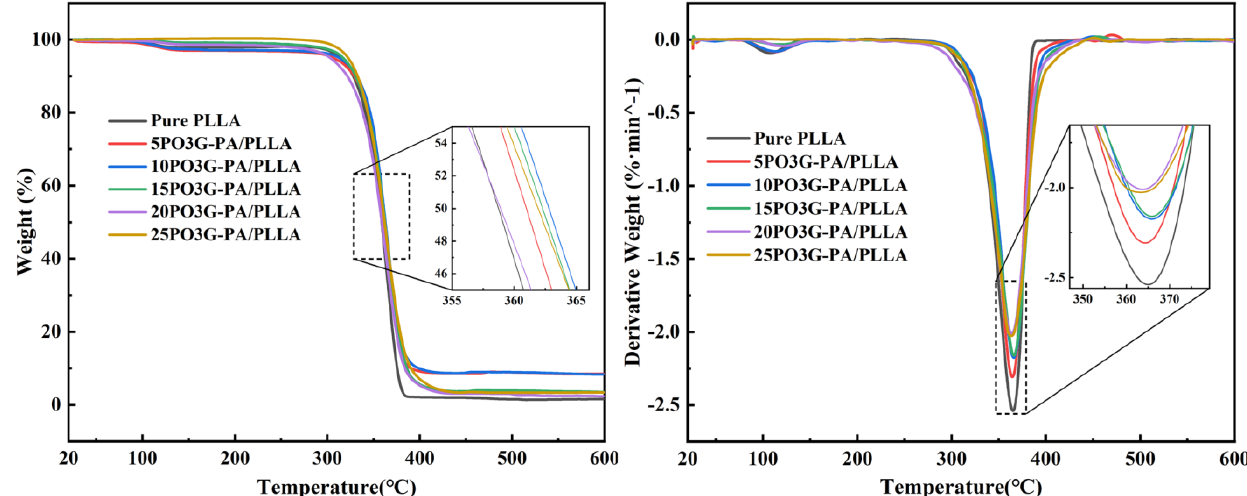
7 of 15 Figure 4. Infrared spectra of PO3G–PA/PLLA composite films with different ratios.